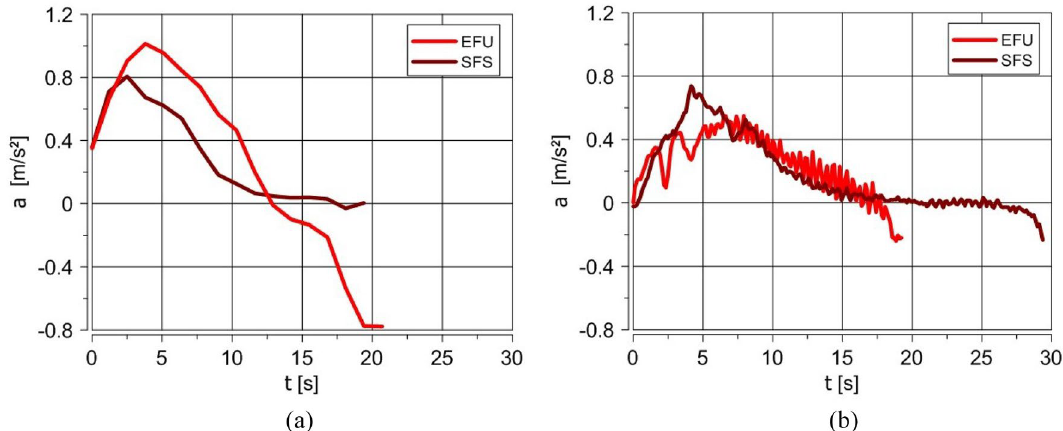
Figure 8. The comparison of truck acceleration for standard and EFU fueling for an empty ( a ) and loaded truck ( b ) (EFU—Emergency Fueling Unit, SFS—Standard Fuel System). (Source: